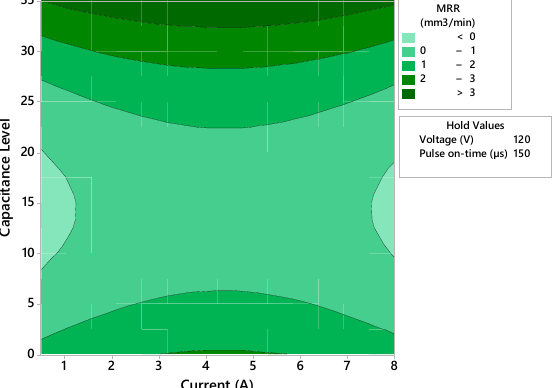
Figure 12. Contour diagram that relates the material removal rate to the two main machining pa- rameters.